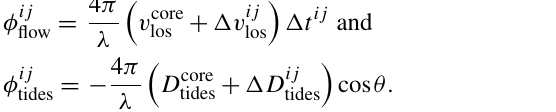
continuous strain field created by rifting